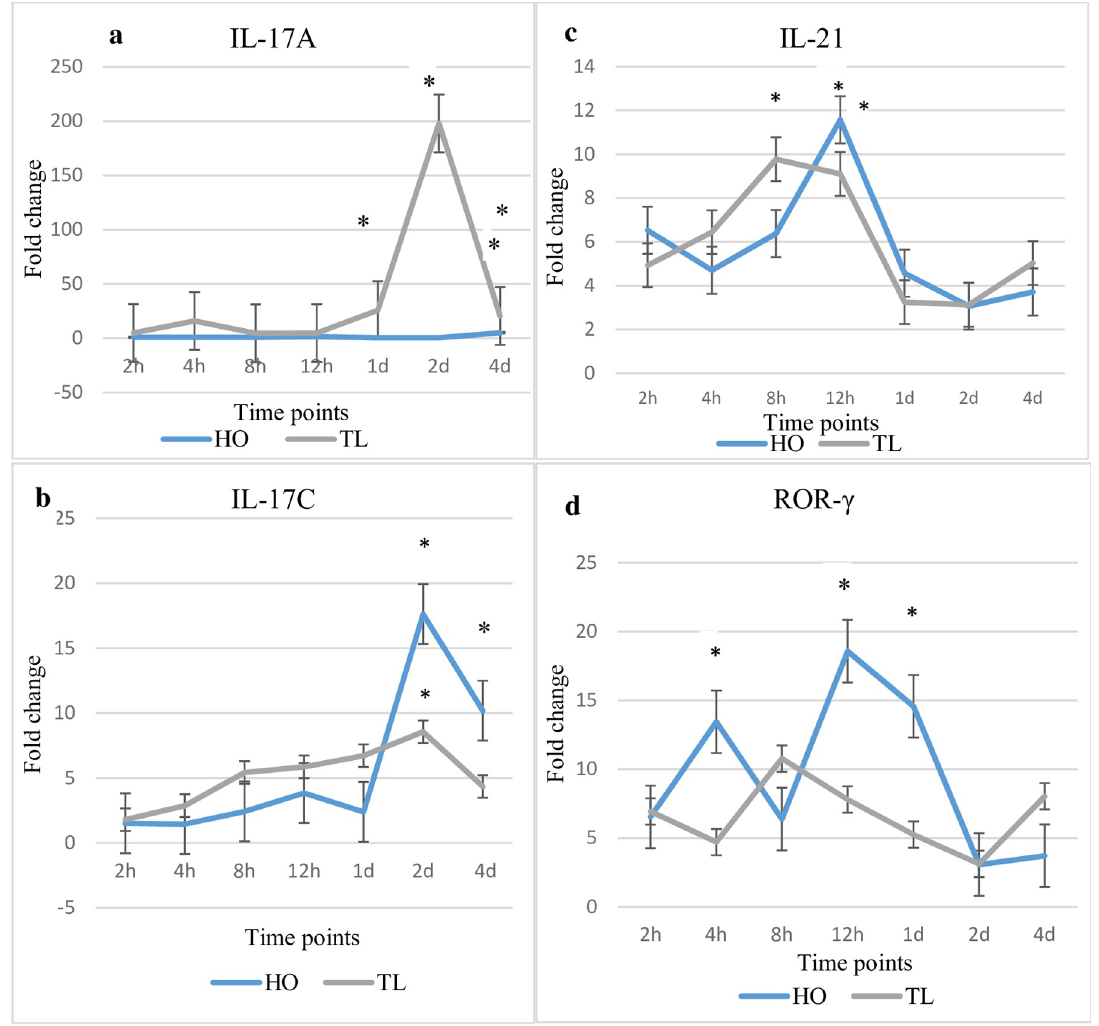
Fig 4. Transcription levels of IL-17A, IL-17C, IL-21 and ROR- γ . The figure shows the mean fold change of the genes in M . cerebralis exposed HO and TL fish. Lines are the mean fold change of IL-17A, IL-17C, IL-21 and ROR- γ measured at different time points post exposure hpe/dpe. All HO and TL means are presented normalized to HO and TL timed levels of control fish ± SD (n = 5). � = significantly higher and § = significantly lower to values in non-exposed fish (p < 0.05).